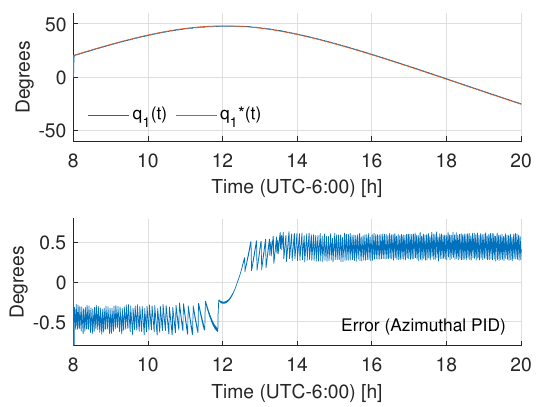
Figure 14. Tracking behavior for the azimuthal axis (PID